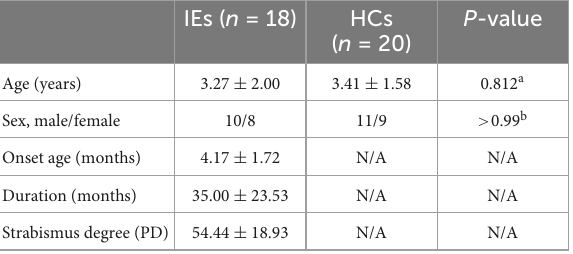
TABLE 1 Demographical and clinical features of the